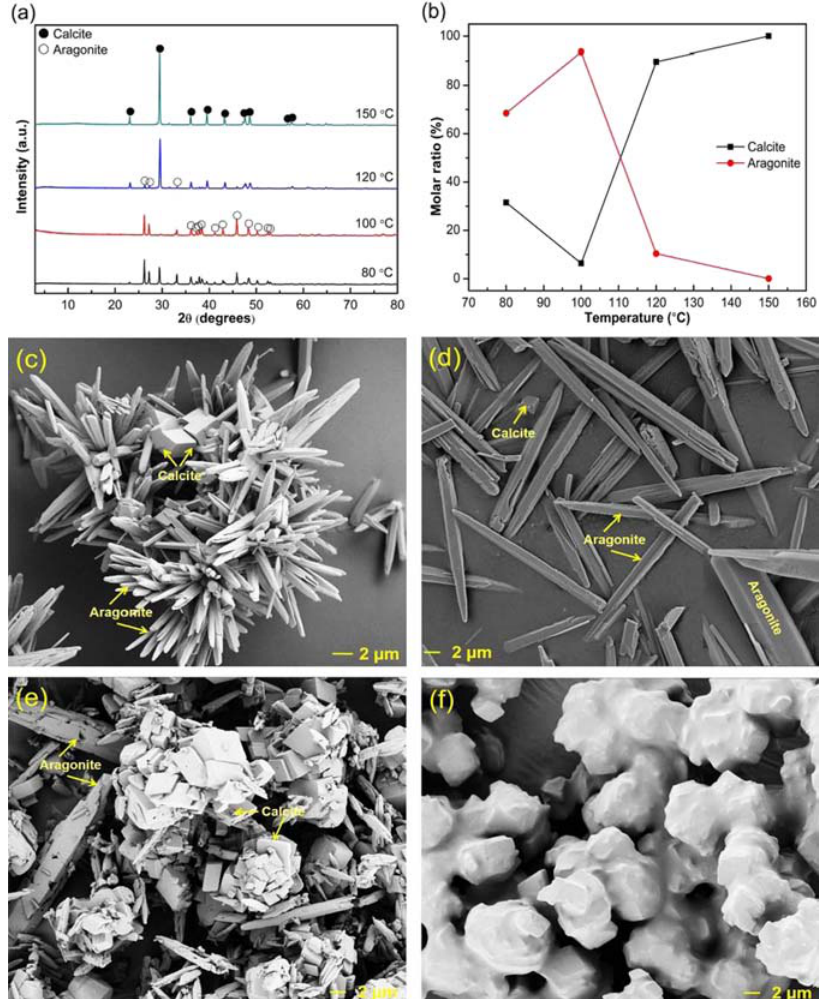
Figure 2: E ff ect of reaction temperature on crystal phase and morphology: ( a ) XRD patterns of the product, ( b ) composition of the products calcite and aragonite, and SEM images of the product at ( c ) 80°C, ( d ) 100°C, ( e ) 120°C, and ( f )